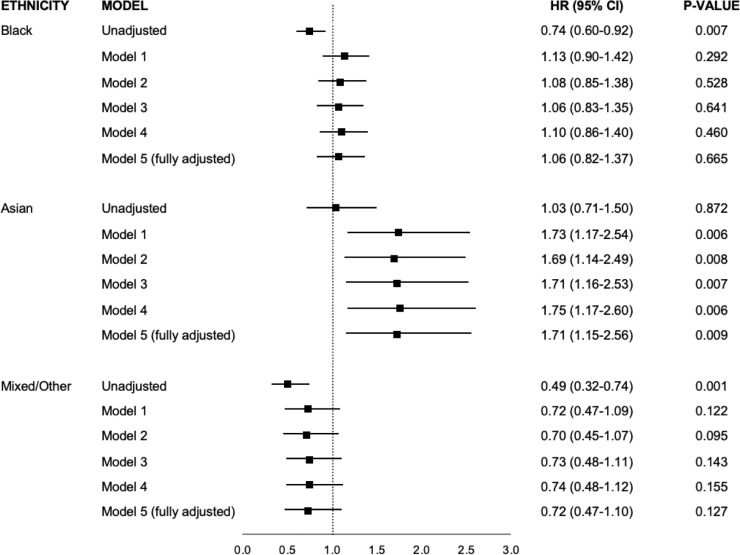
Association between ethnicity and risk of in-hospital mortality with COVID-19.Hazard ratios are compared to White ethnicityModel 1 – adjusted for age and sexModel 2 – adjusted for age, sex and index of multiple deprivationModel 3 – adjusted for age, sex and cardiometabolic comorbidities*Model 4 – adjusted for age, sex, and all comorbidities**Model 5 (fully adjusted model) – adjusted for age, sex, index of multiple deprivation, and all comorbidities*Cardiometabolic comorbidities include hypertension, coronary heart disease, heart failure, previous stroke/TIA, diabetes, chronic kidney disease.**Cardiometabolic comorbidities, asthma, chronic obstructive pulmonary disease.